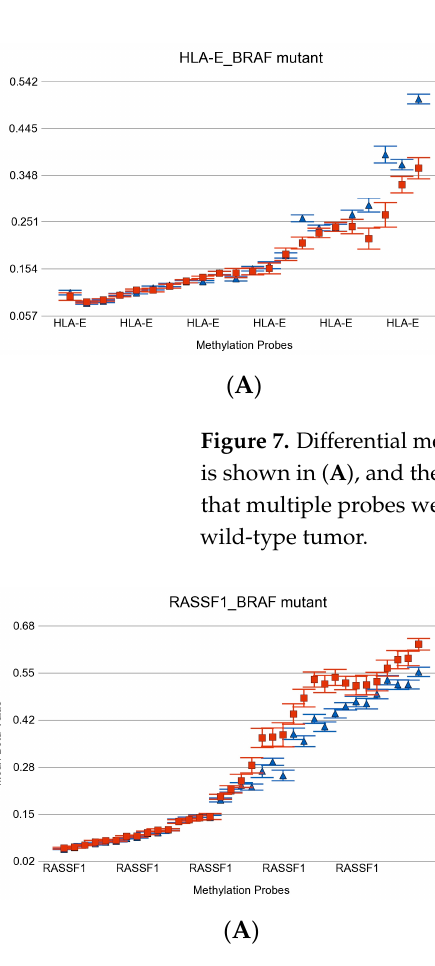
Figure 8. Differential methylation status of RASSF1 . Differential methylation in BRAF mutant pa- tients is shown in ( A ), and the differential methylation of BRAF wild-type patients is shown in ( B ). Multiple probes were hypermethylated in both groups. However, the overall magnitude was slightly higher in wild type.